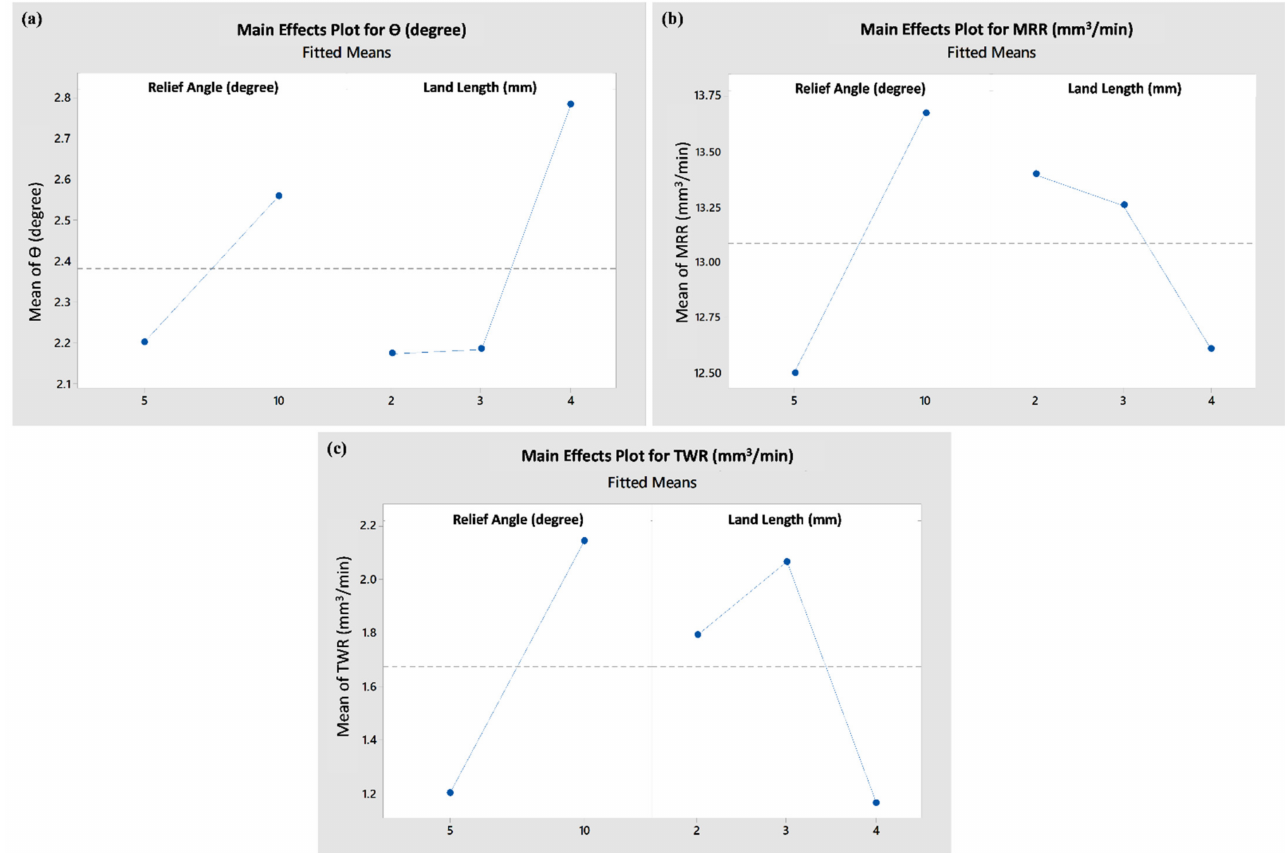
Figure 12. Main effects plots for ( a ) hole taper angle, ( b ) material removal rate, and ( c ) tool wear